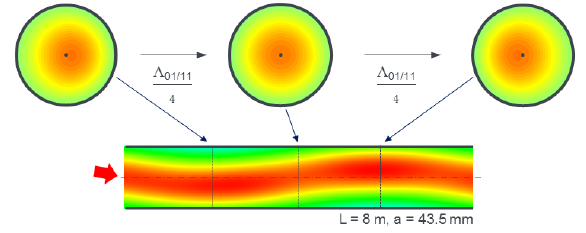
Figure 1. Resutling field in the OCCWG over a length of 8 m for a tilted input beam (0.15 ◦ tilted J 0 resulting in 98.8 % LP 01 and 1.2 % LP 11 ).